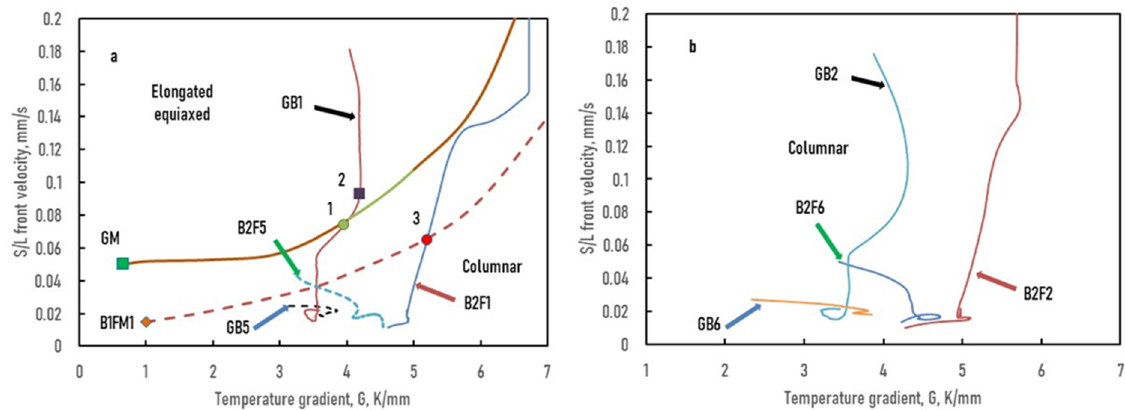
Figure 17. v SL ( G SL ) paths of the CETSOL Batch2 microgravity (B2F) and the ground-based (GB) ex- periments; ( a ) samples contain GR, ( b ) samples do not contain GR.